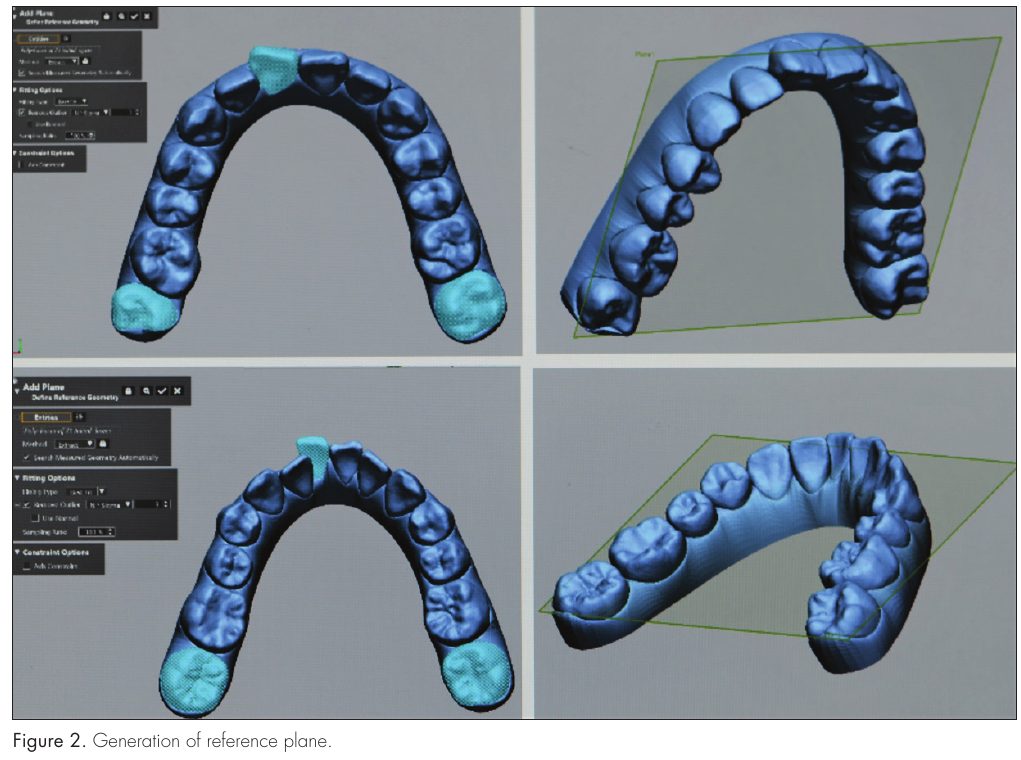
Figure 2. Generation of reference plane.